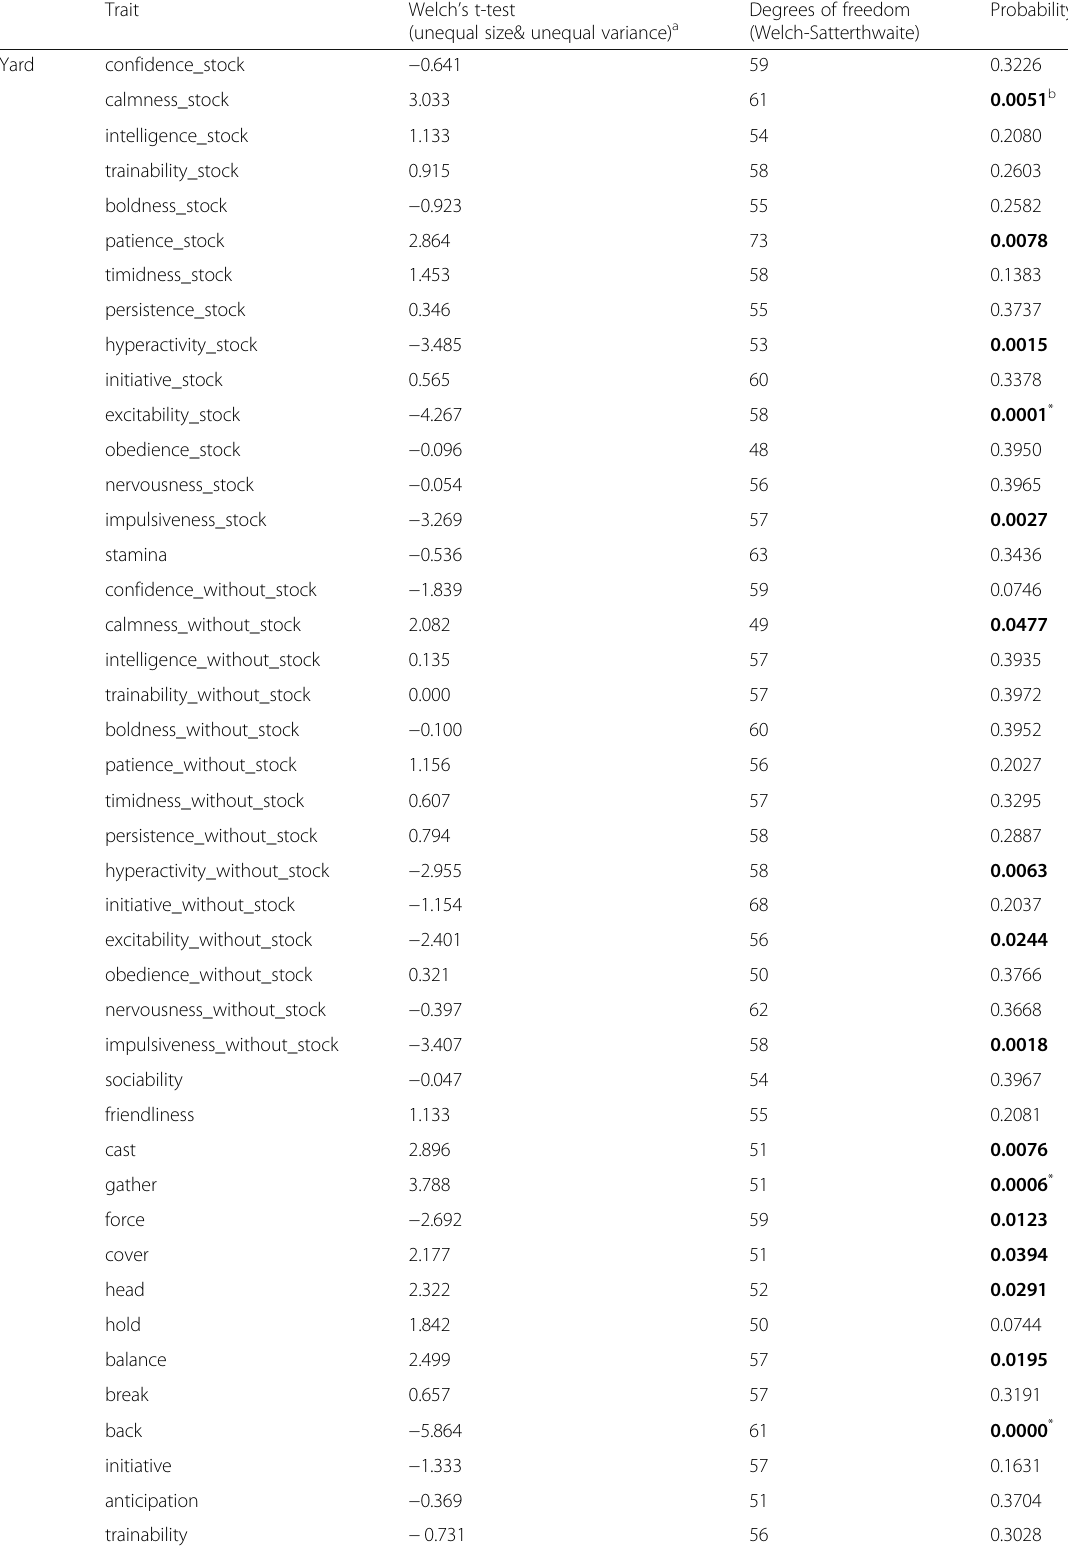
Table 1 Pairwise comparison of work-type in the Australian Working Kelpie over 63 traits